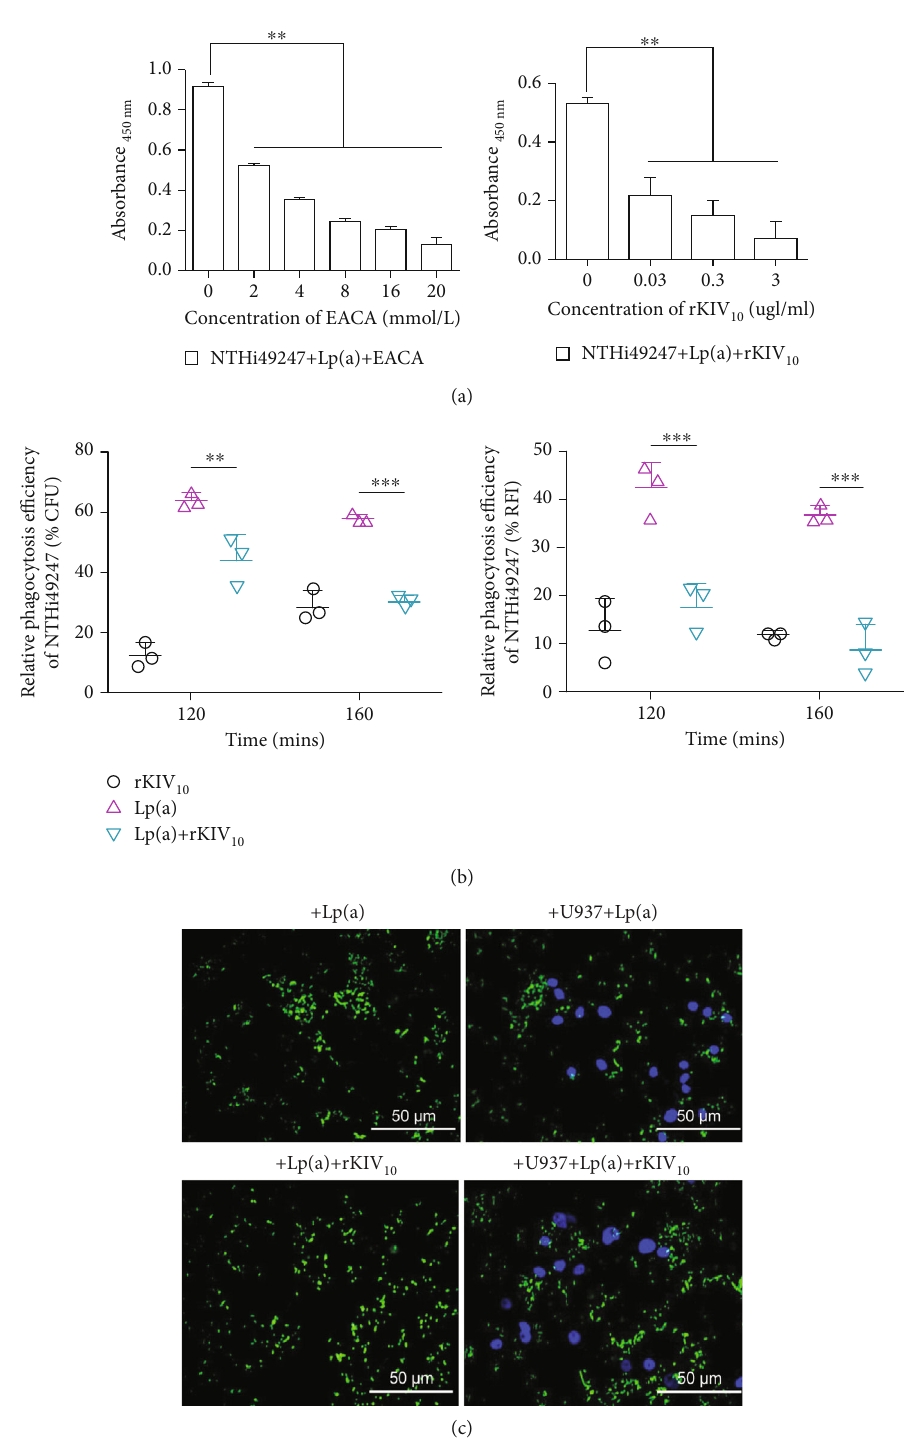
Figure 4: Increase in response to Lp(a) was largely inhibited by the addition of rKIV . Whether the interaction between NTHi and Lp(a) 10 was lysine-dependent was determined by whole-cell ELISA. The mixture of Lp(a) and di ff erent concentrations of EACA (0-20mM) and rKIV (0.03-3 μ g/mL) was used. (a) The binding of Lp(a) to intact NTHi was inhibited by two inhibitors in a dose-dependent manner. 10 Statistical signi fi cance was determined by two-way ANOVA and the Bonferroni post hoc test. (b) Inhibition of Lp(a)-mediated phagocytosis of NTHi49247 by rKIV was estimated by CFU counts and RFI measurements. (c) Representative photographs of rKIV - 10 10 or Lp(a)-treated FITC-NTHi49247 (green) incubated with or without macrophages stained with DAPI (blue). The MOI of NTHi49247 was 56:1. Data are represented as means ± SD from three independent experiments. Assays were conducted on at least three separate occasions. Statistical signi fi cance of the di ff erences between groups in the phagocytosis assay was determined by two-way ANOVA and the Bonferroni post hoc test. ∗∗ P < 0 : 01 , ∗∗∗ P < 0 : 001